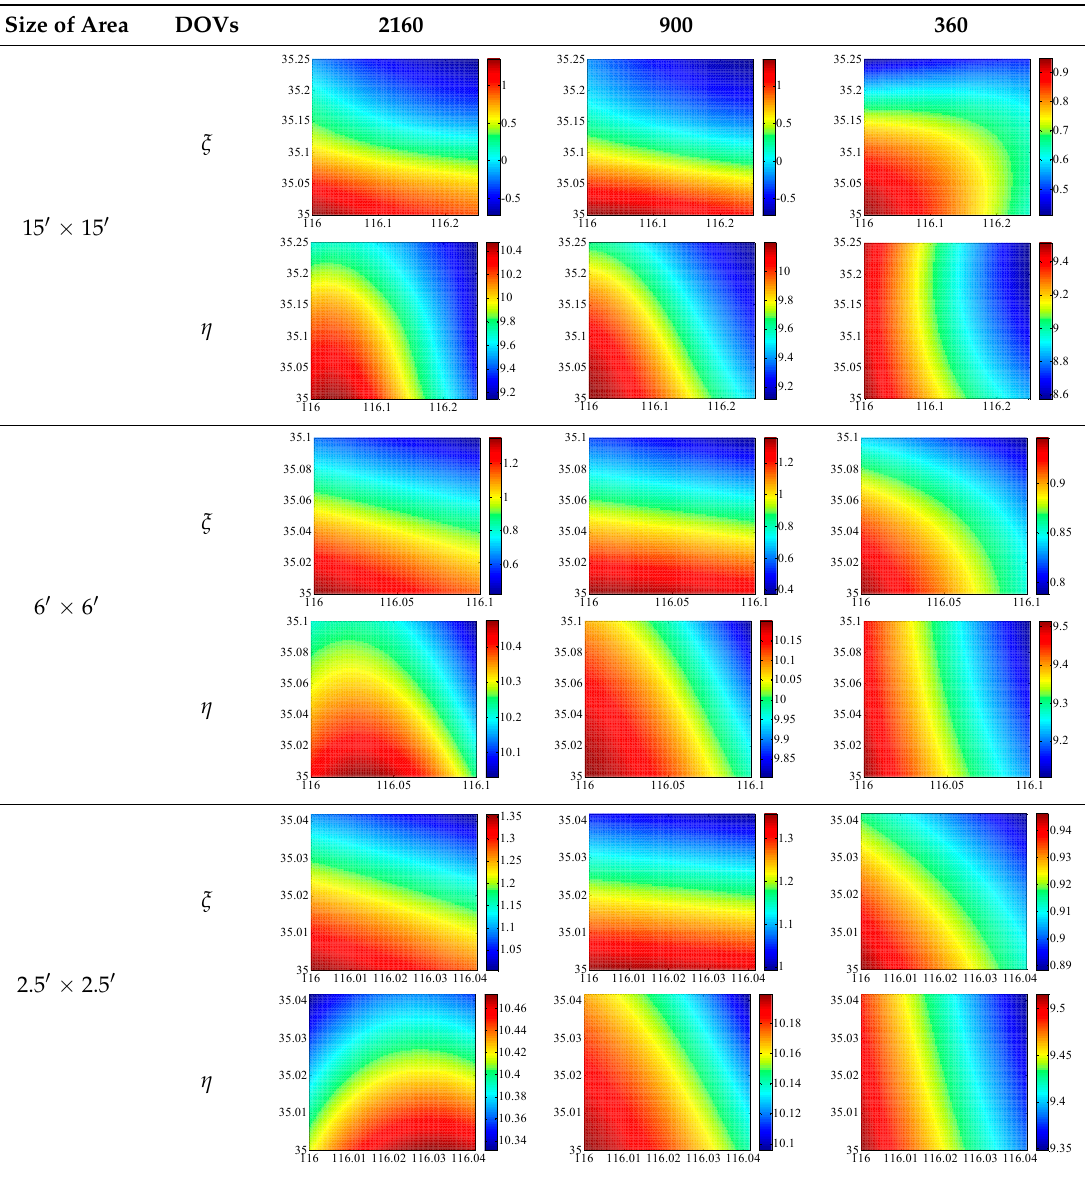
Table 1. DOVs of different area sizes in the North China